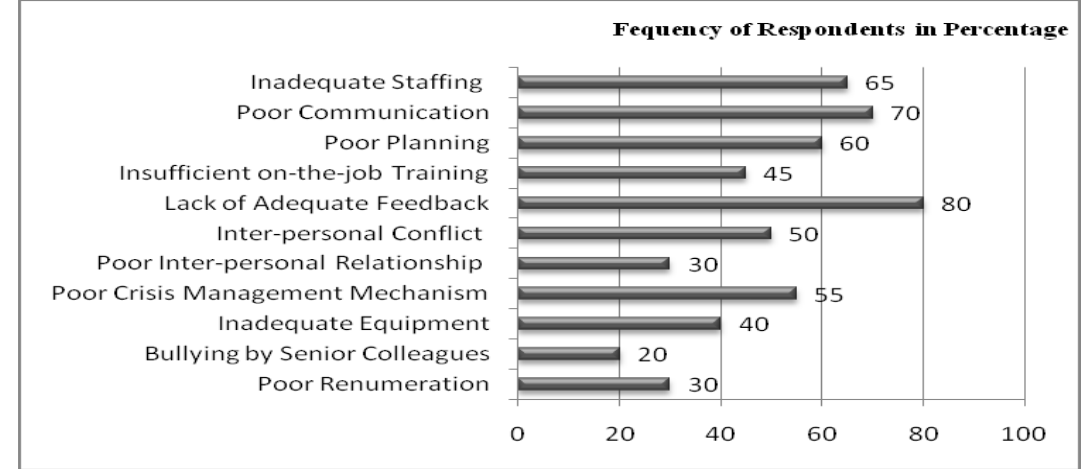
Figure 4 Organizational related stress factors (Source Field survey,